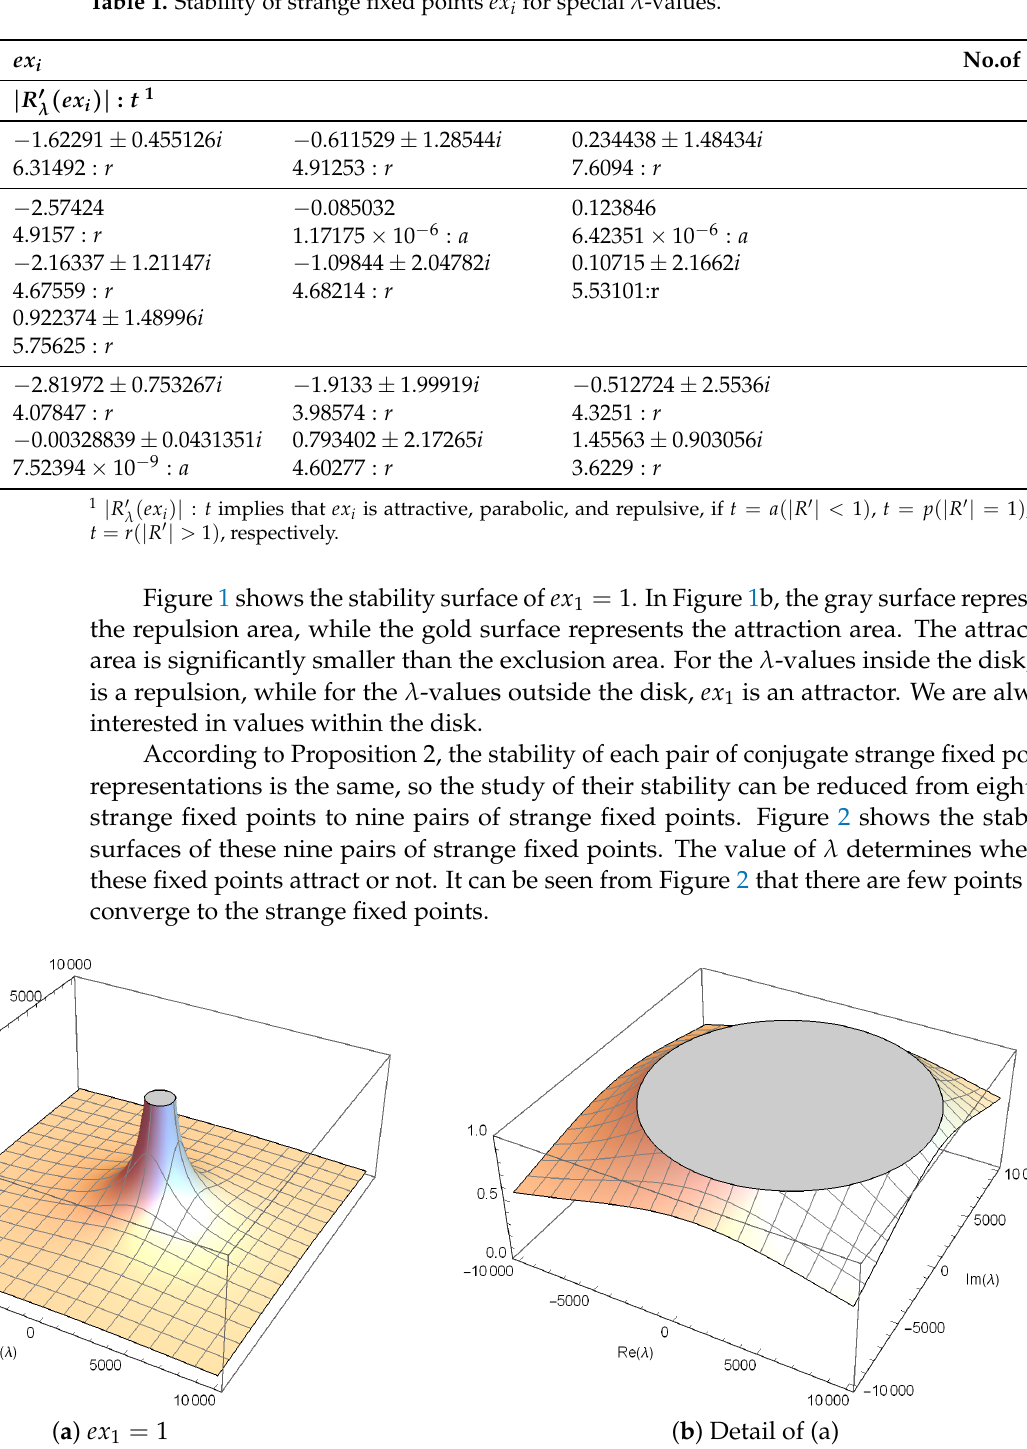
Figure 1. Stability surface of ex 1 =